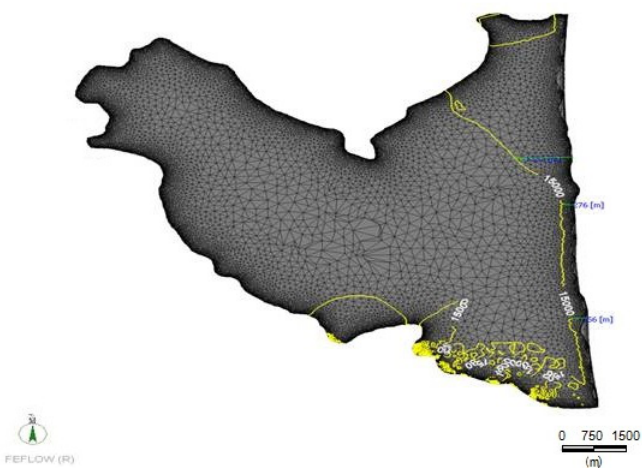
Figure 10. Location of 15,000 mg L − 1 isosalinity contour at 4018 days against wells located at 1800 m from shoreline.